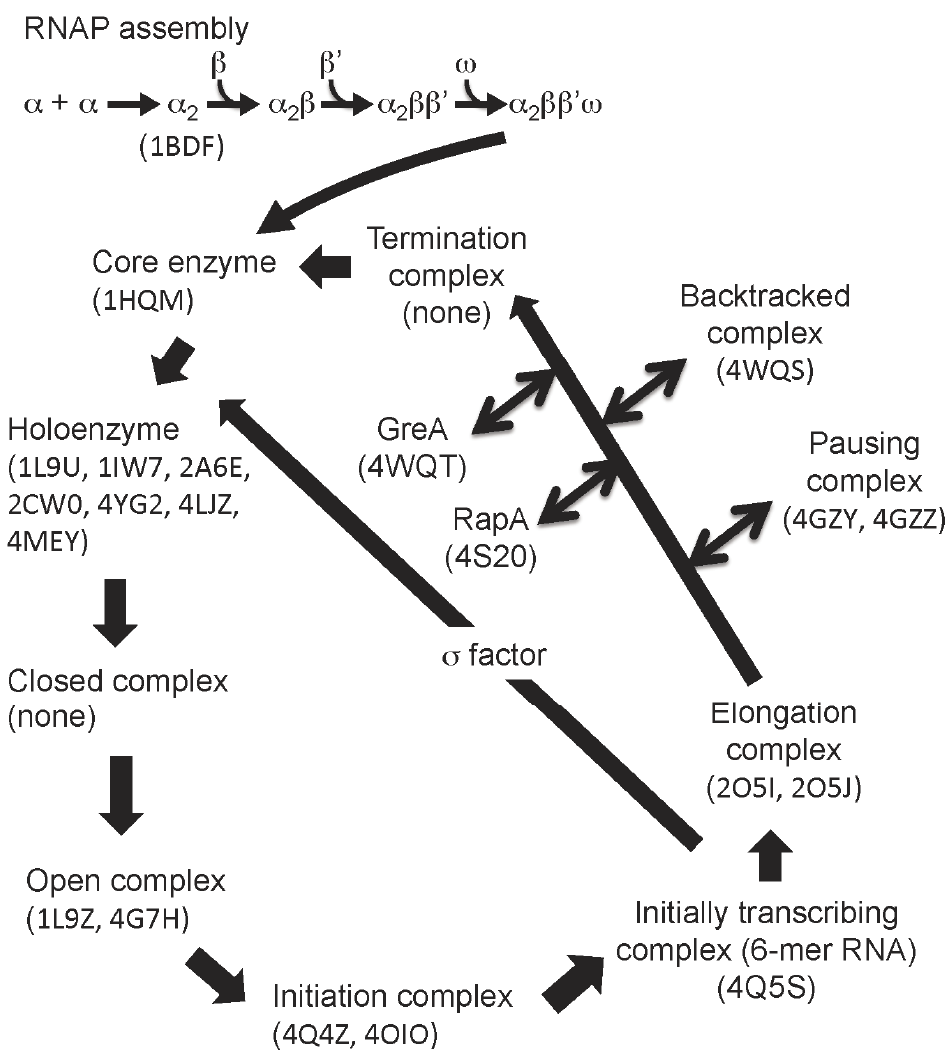
Figure 1. RNAP assembly and transcription cycle. The figure shows the general scheme for bacterial RNAP assembly and the transcription cycle. PDB codes of RNAP structures (in brackets) belonging to each phase of the transcription